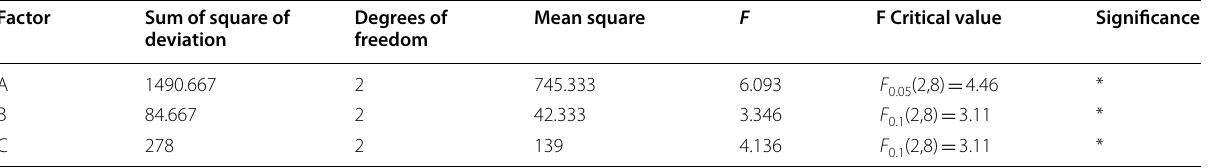
Table 12 ANOVA of liquidity test results Factor Sum of square of deviation